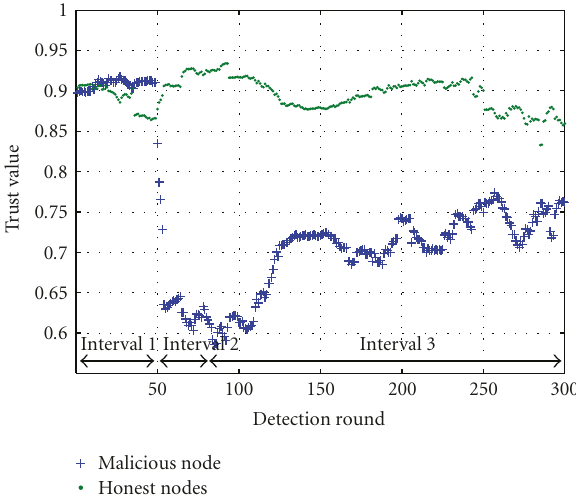
Figure 11: Dynamic trust value in proposed scheme (a user attacks during time [50,55], P a = 1).